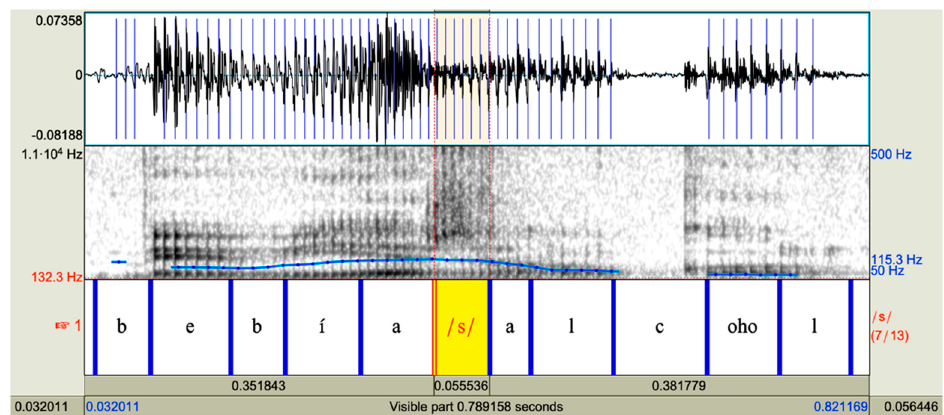
Figure 4. Older L1-Catalan male rendition of bebía/s/ alcohol (‘you drank alcohol’) in Barcelonan Spanish (~100% voiced).